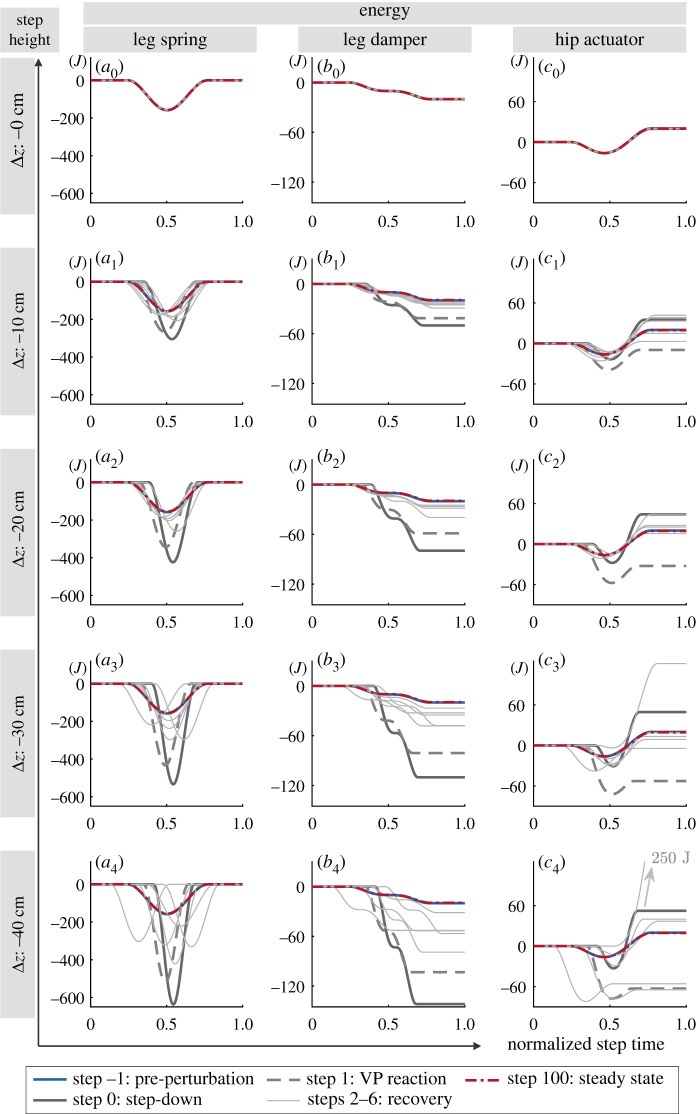
The trunk pitch angle (a), forward speed (b), vertical speed (c), and trunk angular velocity (d) of the simulated gaits. The figure is complementary to figure 7a, which provides the centre of mass trajectories. The solid lines correspond to the stance phase, whereas dotted lines correspond to the flight phase of running in simulation. The step-down perturbation leads to a deviation from the equilibrium state. At the end of the perturbed step (dark grey lines), the forward trunk lean is less, forward speed is higher, and trunk angular velocity is higher than the equilibrium conditions. The step after perturbation (red lines) is the step, where the leg angle and VP controllers react to the changes in state.